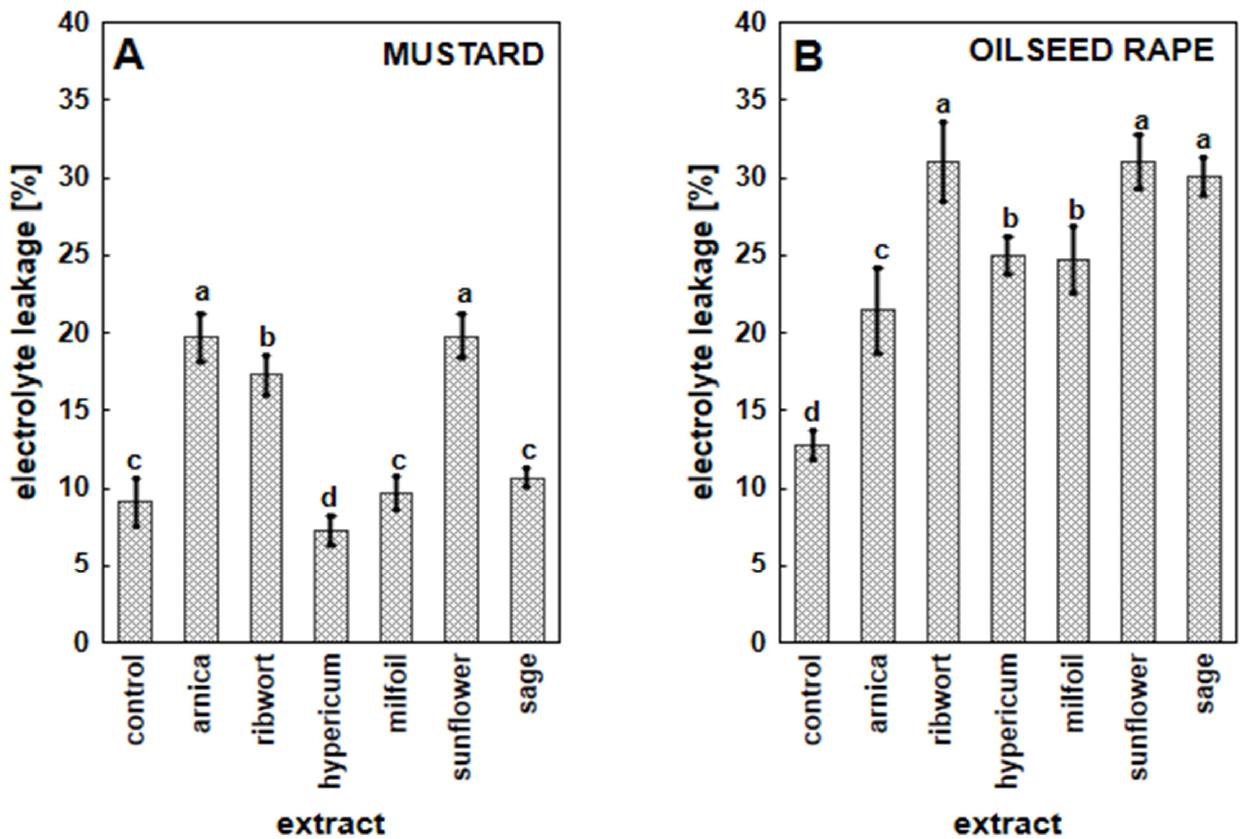
Figure 5. Membrane permeability expressed as changes in the electrolyte leakage of the white mustard ( A ) and oilseed rape ( B ) seedlings that were growing in the presence of the extracts from arnica, ribwort, hypericum, milfoil, sunflower, sage and water (control). Mean values ± SD indicated by the same letters did not differ significantly at p ≤ 0.05 according to the Duncan’s test (within the tested species), n = 10.